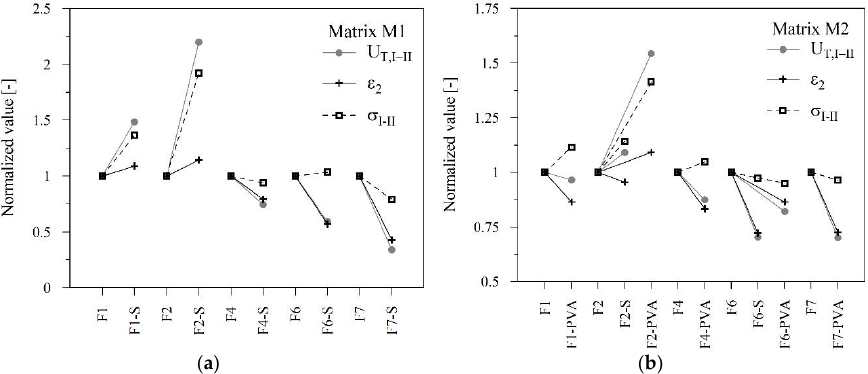
Figure 12. Efficiency factors in uniaxial tension for M1-based ( a ) and M2-based ( b ) TRC composites.